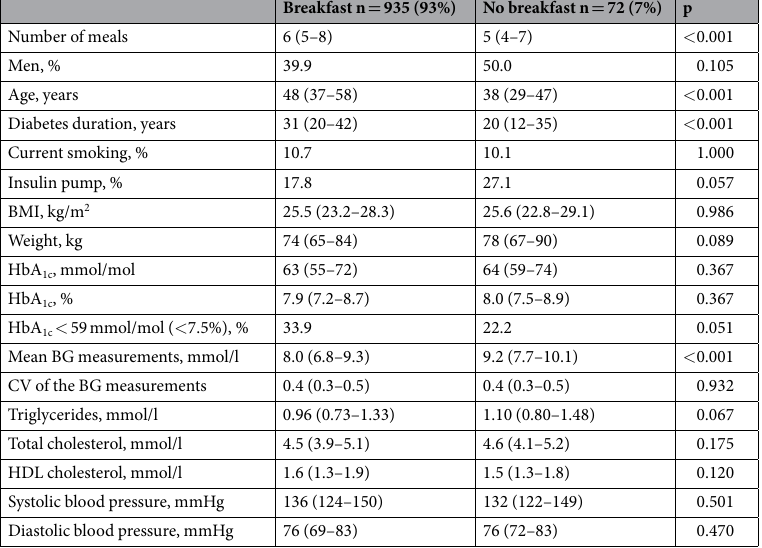
We then investigated whether skipping breakfast was associated with glycaemic control. Adjusted for sex, diabetes duration, smoking, energy intake, physical activity and mode of insulin administration, we observed that breakfast skipping was associated with reduced odds of achieving good glycaemic control (Table 5). Moreover, skipping breakfast was associated with higher mean of the reported blood glucose measurements (adjusted means